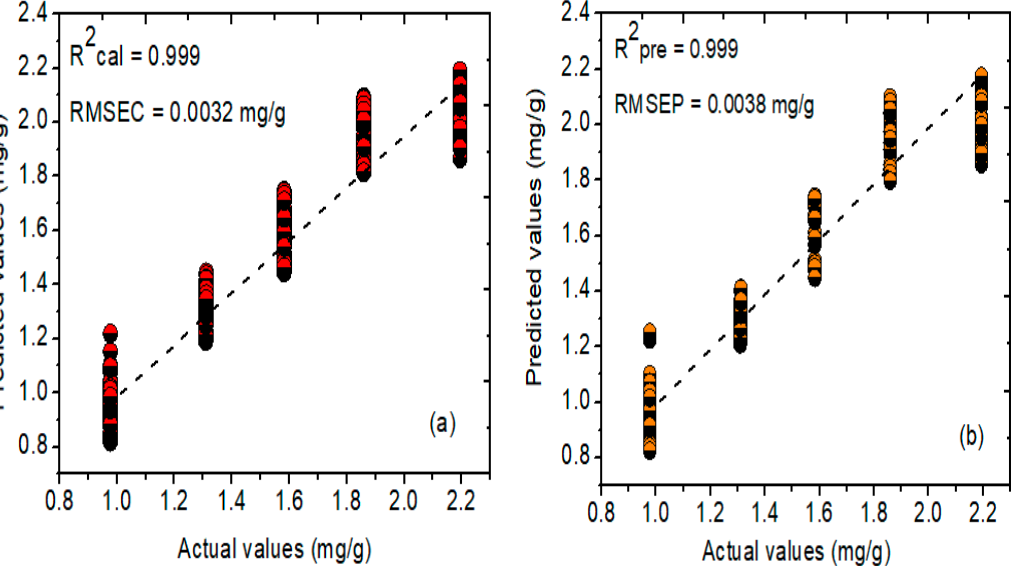
Figure 11. Actual and predicted concentration values for the phenolic compounds in A. thaliana leaf powder samples using the PLSR model for ( a ) calibration and ( b ) prediction datasets. Here, RMSEC and RMSEP represent the root-mean-square error for calibration and prediction, respectively.